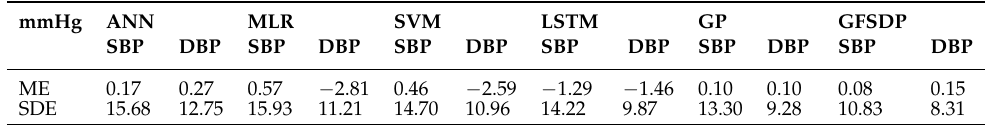
Table 9. ME and SDE relative to the reference ABP and the conventional ANN, MLR, SVM, LSTM, GP algorithms and using the proposed GFSDP algorithm.